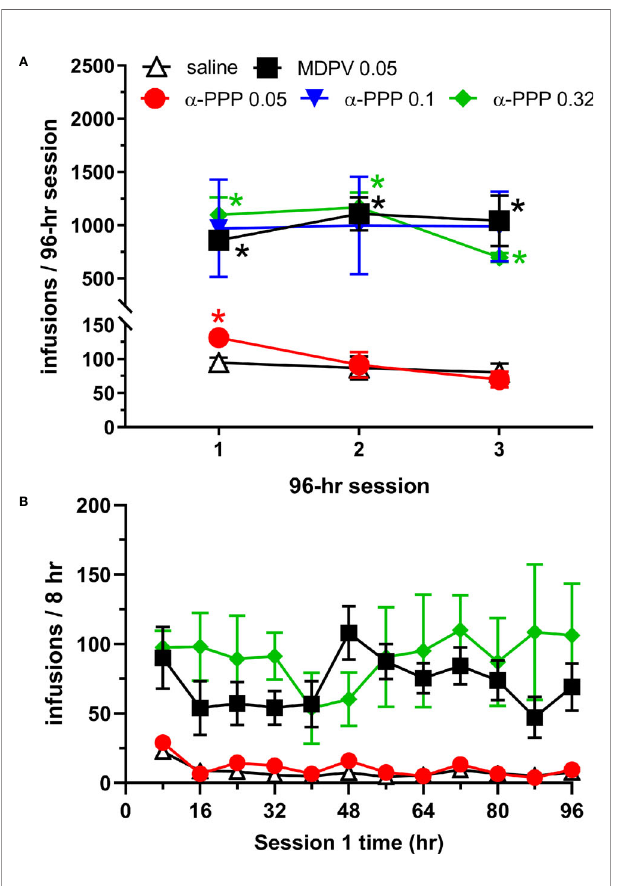
FIGURE 1 | (A) Total infusions of saline (n = 6), MDPV (n = 6), or one of the three doses of a -PPP (0.05, 0.1. or 0.32 mg/kg/infusion, n = 8, 4, and 4, respectively) during each of the three 96-h self-administration sessions. * indicates p<0.05 vs. the number of saline infusions obtained during the same 96-h session. (B) Total number of infusions of a -PPP (0.05 and 0.32 mg/kg/infusion), MDPV, or saline obtained in 8-h time bins during the fi rst 96- h self-administration session. See Table 1 for statistical signi fi cance of individual groups and time points. Data from the 0.1 mg/kg/infusion group are not shown to enhance clarity of the data presented, and as a result of lack of statistically signi fi cant overall intake observed. All data are presented as mean ± SEM.